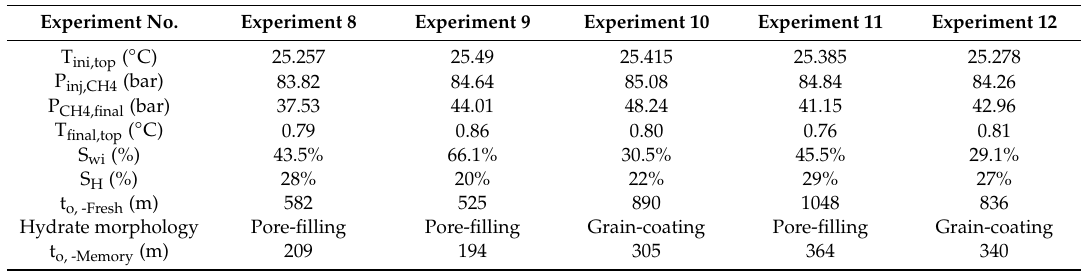
Table 5. Methane hydrate formation under the presence of methanol (before soaking = BS, after Soaking = AS). Experiment